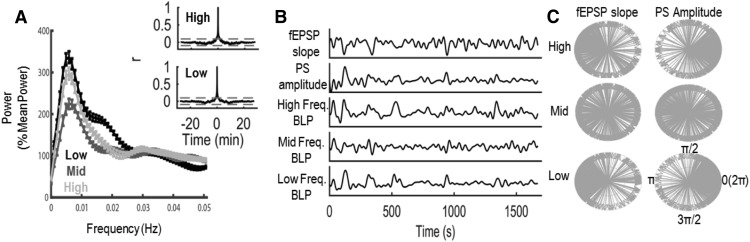
Phase-locking of EEG BLP, fEPSP slope, and PS amplitudes. A, Average power spectra (n = 17 rats) of low-, middle-, and high-frequency BLP during the entire recording session. Insets, Autocorrelograms for infraslow-filtered high- and low-frequency BLP. Gray dotted lines depict 95% confidence intervals. B, Spontaneous fluctuations in evoked response magnitude and EEG BLP are evident in infraslow filtered time series data from a single rat. C, IPDs calculated at each data point across the time series data depicted in B. Each gray arrow represents the phase difference calculated at a single time point. fEPSP and low-/high-frequency BLP are typically out of phase (π radians), while PS amplitude and low-/high-frequency BLP are typically in phase [0(2 π) radians]. No clear phase locking is present between middle-frequency BLP and fEPSP slope or PS amplitude.